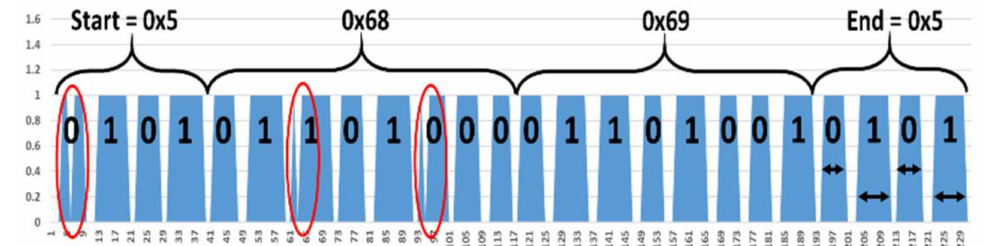
Figure 12. Decoding a “hi” message ( h = 0 × 68 and i = 0 ×